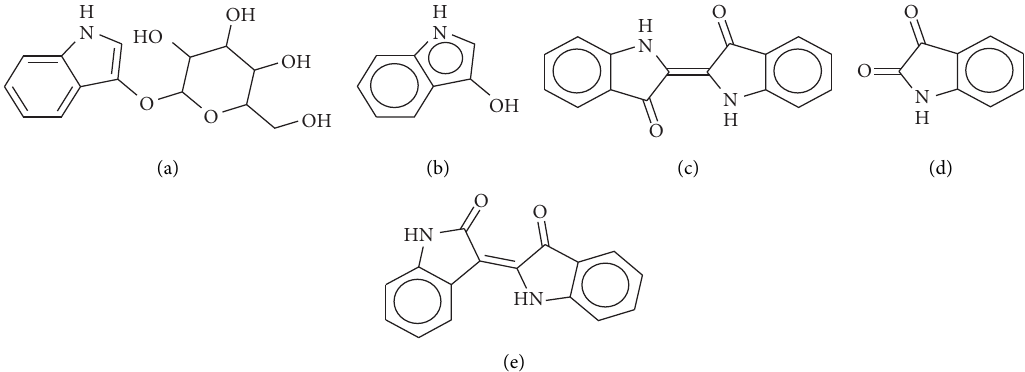
Figure 1: Indigo precursors in plants: (a) indican, (b) indoxyl, (c) indigotin, (d) isatin, and (e) indirubin.